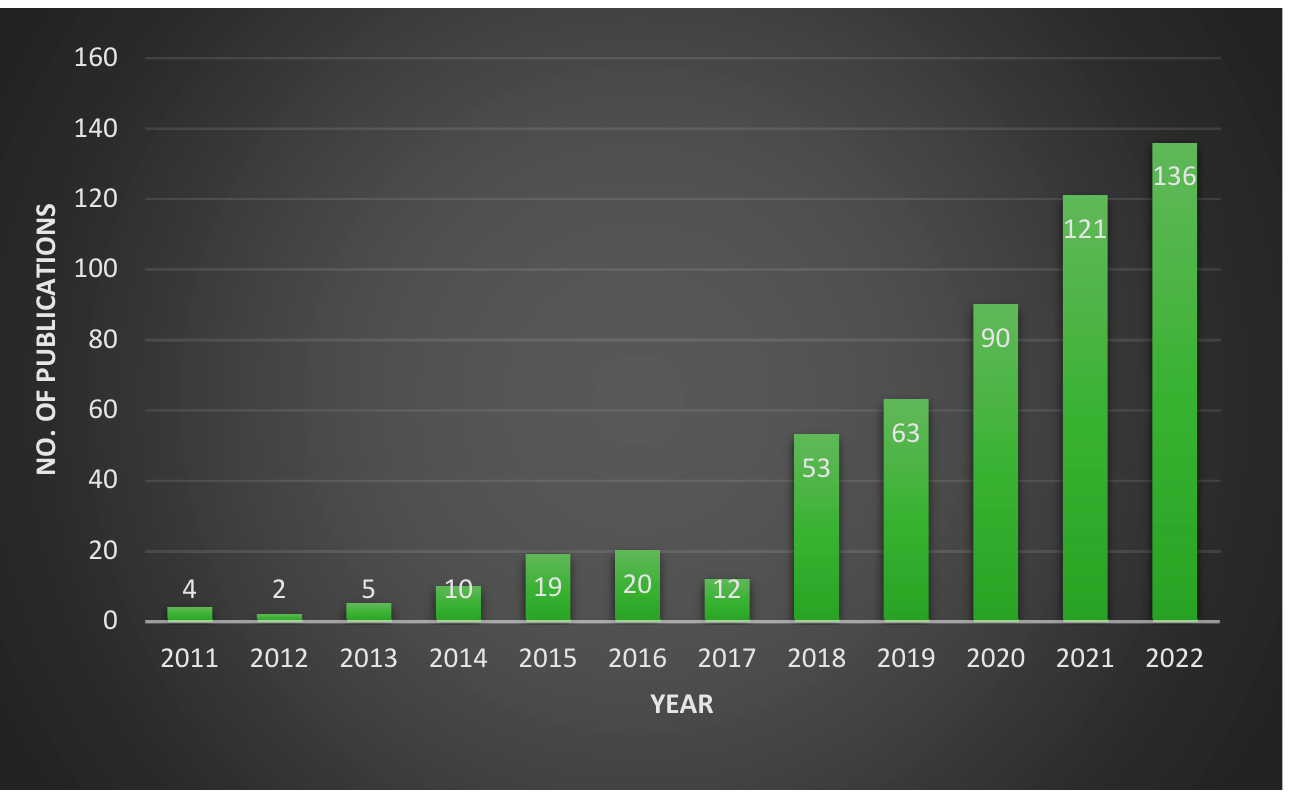
Figure 1. No. of publications “Bismuth based heterostructure” (data obtained from Scopus on 30 September 2022).